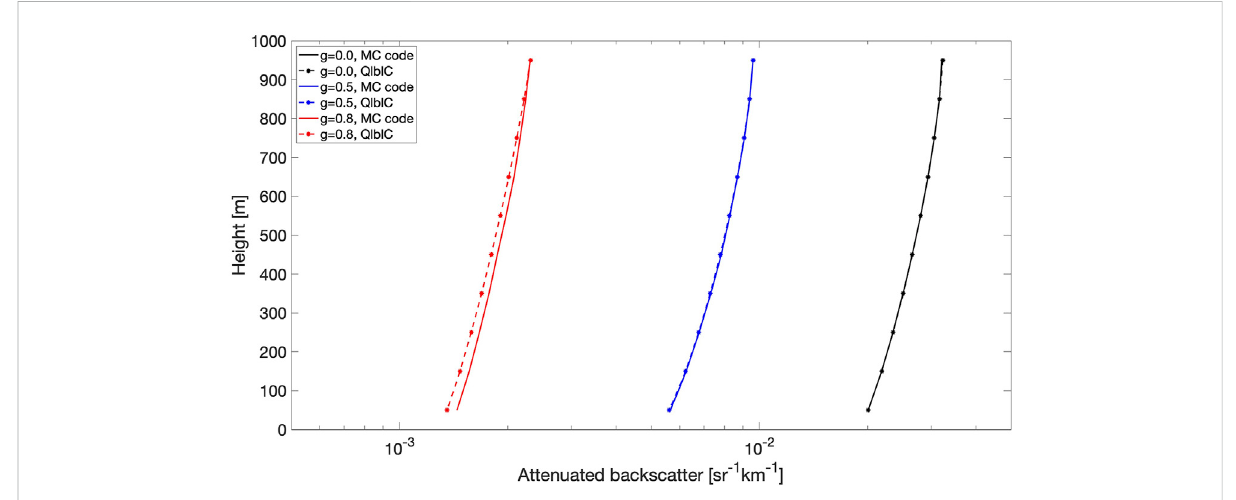
FIGURE 7 Attenuatedbackscatterpro fi lescomputedbytheMCcodeandtheAccuRTQlblCcodeforthecasedisplayedinFigure6fora1,000 mthickslab of total optical thickness τ b =